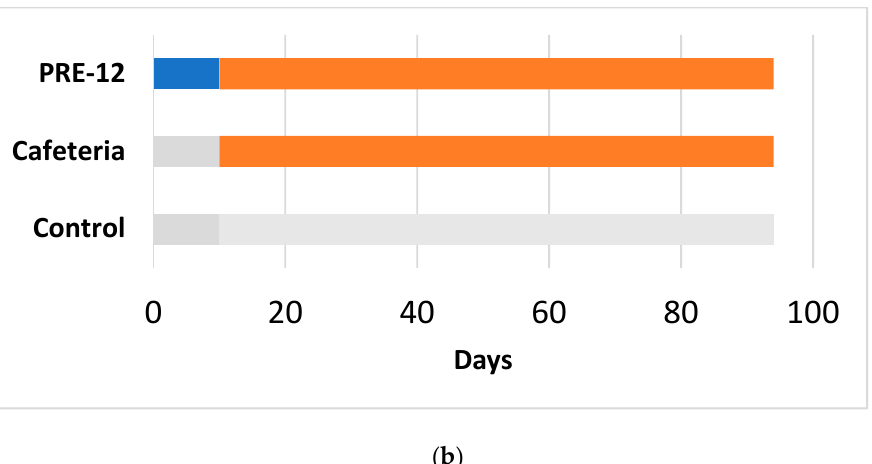
Figure 1. Experimental design for the 17-week ( a ) and 12-week ( b ) cafeteria studies. Control groups received a standard chow diet (grey bar). The other groups received a cafeteria diet (orange bar) for 17 weeks ( a ) or 12 weeks ( b ). The preventive treatment groups (PRE-17) and (PRE-12) received a dose of 500 mg GSPE/Kg (blue bar) for 10 days before starting the cafeteria diet. The simultaneous intermittent treatment-CAF (SIT) group received a five-day dose of 500 mg GSPE/Kg every second week at the same time that they were fed a cafeteria diet.